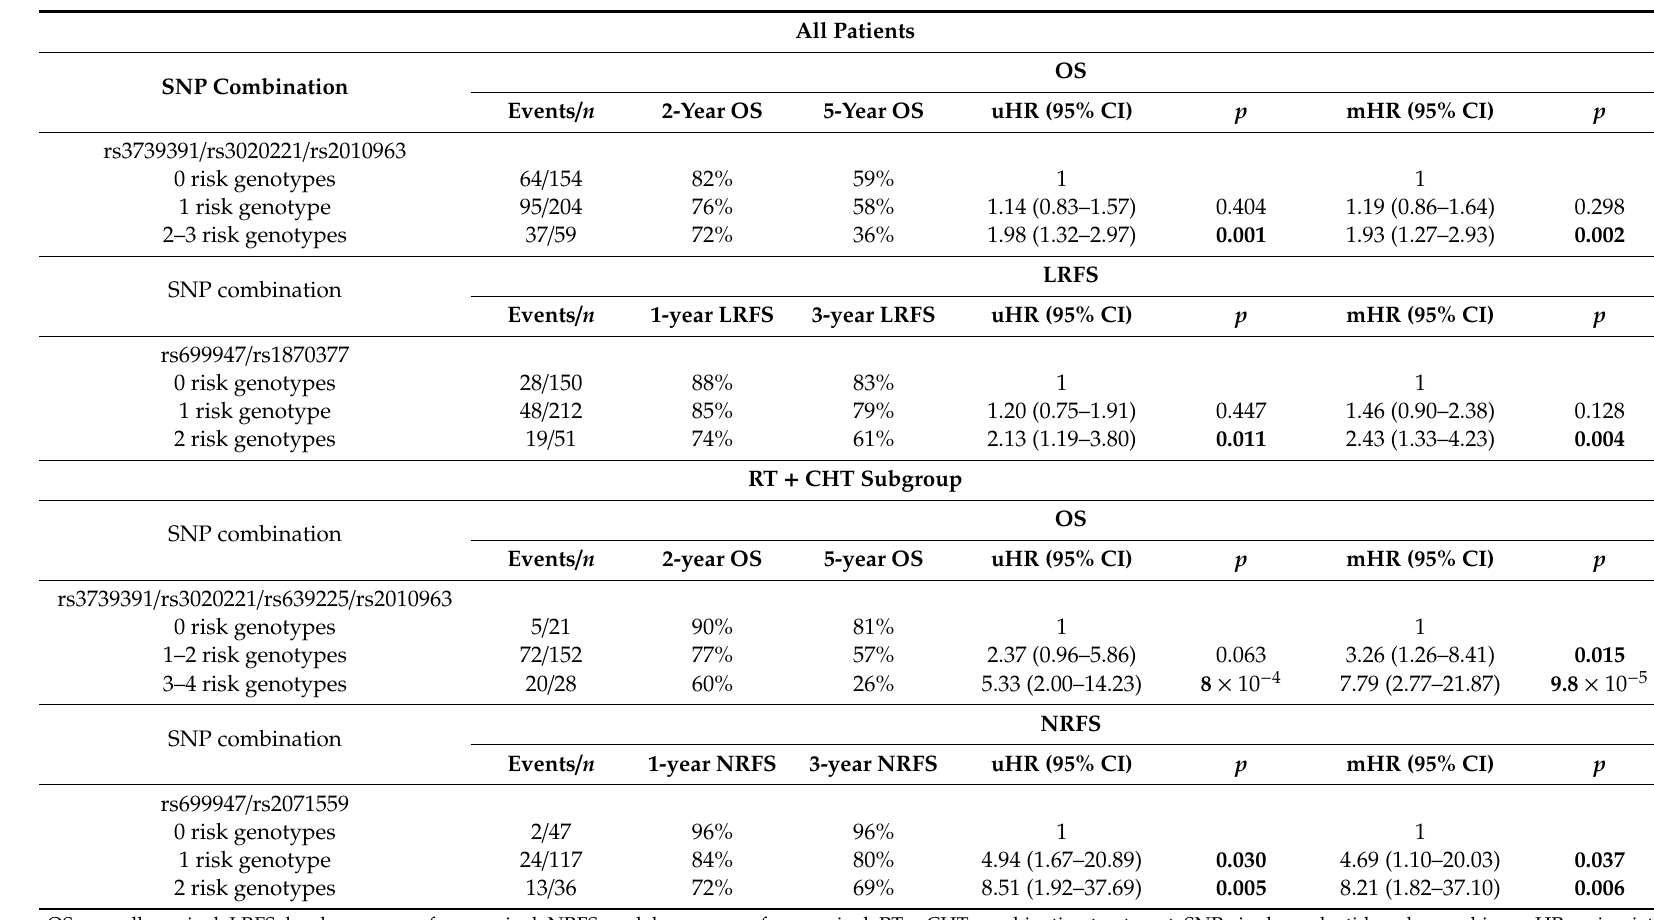
Table 5. Cumulative genetic risk analysis for OS and LRFS in the whole group, and for OS and NRFS in the combination treatment subgroup (RT + CHT). All